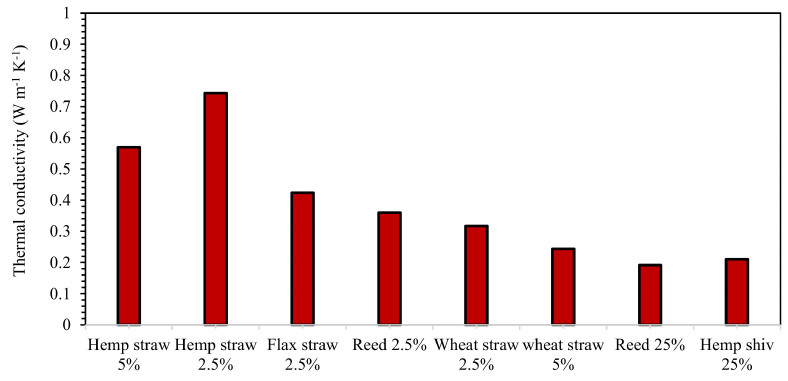
Figure 10. Average thermal conductivity of the cob